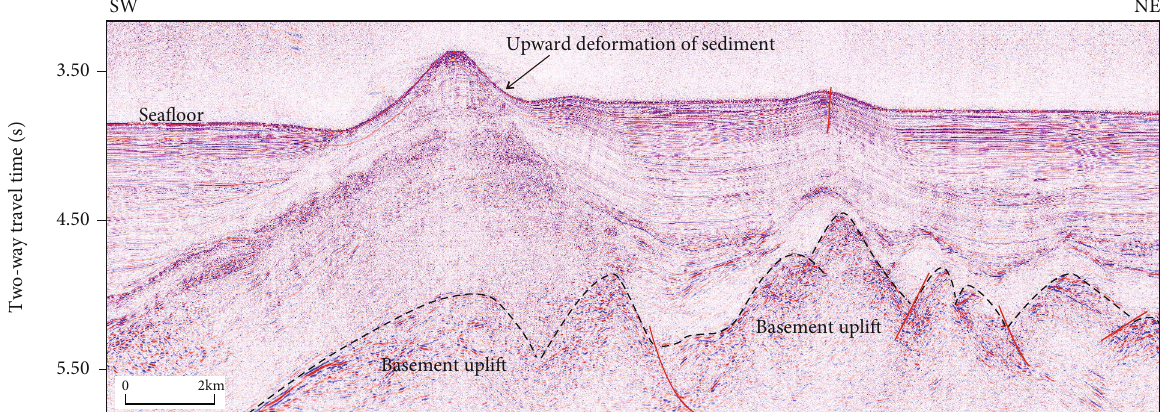
Figure 6: Seismic pro fi le of the Dongsha Islands. The seismic pro fi le reveals a thin Cenozoic sedimentary cover, and the uplift of the Mesozoic basement caused the upward deformation of the overlying sediment.